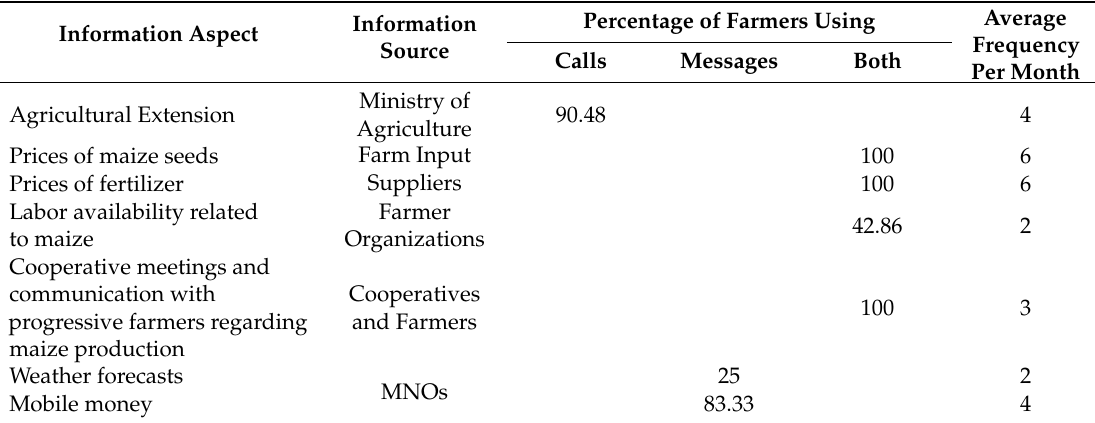
Table 3. Presence and intensity of information access via MP.